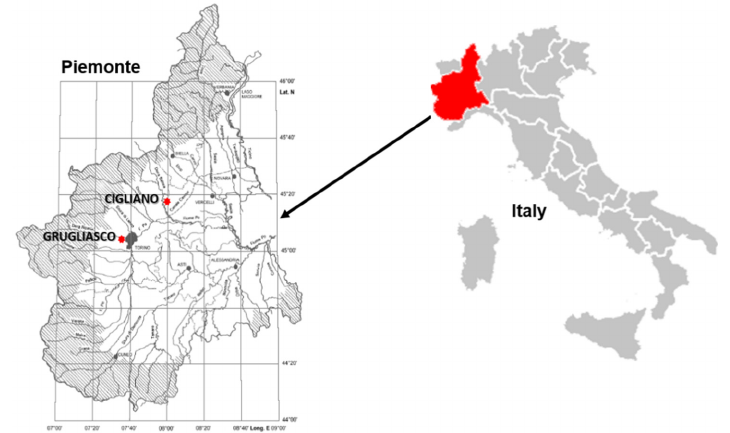
Figure 1. Geographical localization of the study area. The two red icons on the left image identify the two experimental